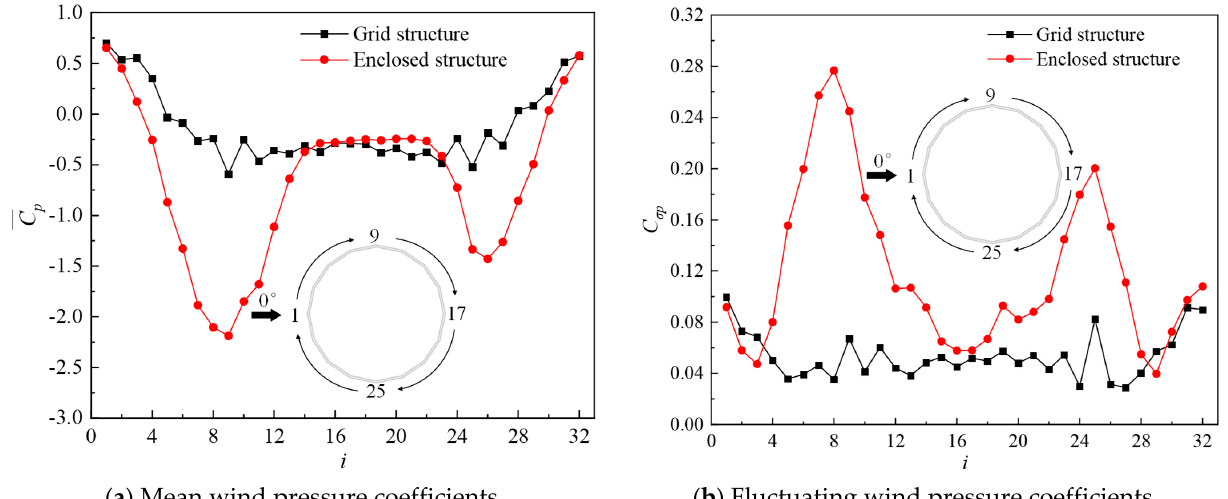
Figure 26. Wind pressure coefficients on the outer surface of the enclosed structure and the grid structure on the 50 m layer at a 0° wind direction angle.